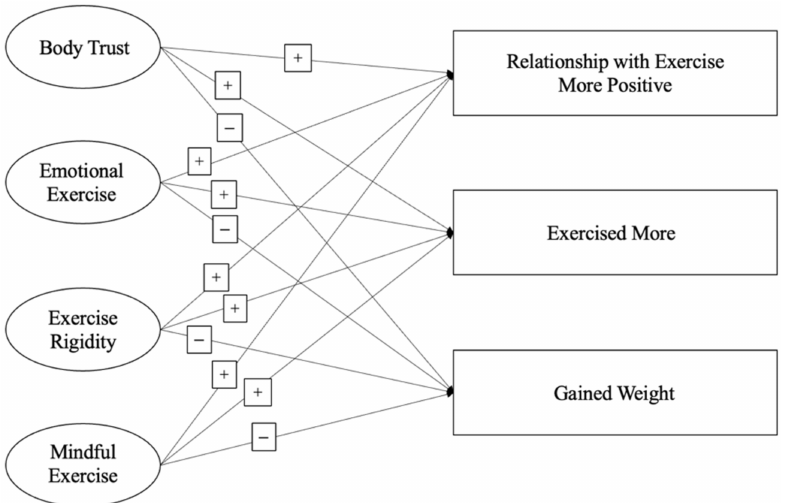
Figure 1. Hypothesized Structural Model for the Relationships between Intuitive Exercise and Attitudes and Behaviors During the Pandemic. Note. Emotional exercise was reverse-scored such that higher scores indicate less emotional exercise. The hypothesized structure remained the same for both intuitive exercise scores before and during the pandemic. Outcome variables always represented exercise attitudes and behaviors during the pandemic. “+” indicates a positive relationship, i.e., that higher (more positive, more intuitive) scores on each of the subscales (Body Trust, Emotional Eating, etc.) on the left are associated with higher agreement with the attitudes and behaviors on the right, whereas “ − ” indicates a negative relationship, i.e., that higher (more positive, more intuitive) scores on the subscales on the left are associated with lower agreement with the attitudes and behaviors on the